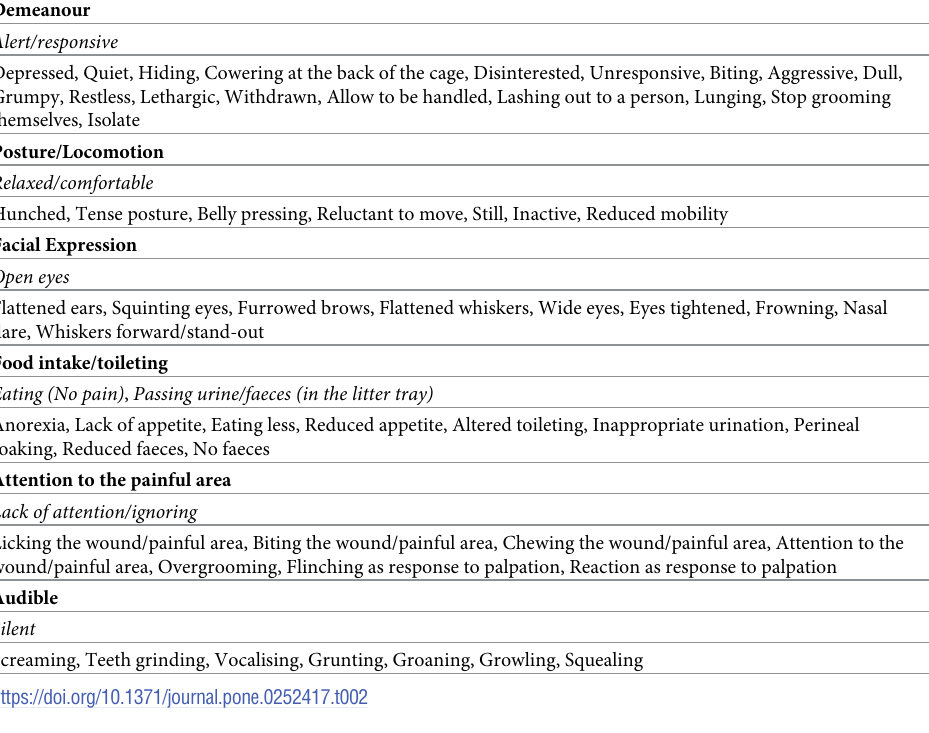
Table 2. Final descriptors and categories chosen during the specialist focus group in phase two. The ‘No Pain’ descriptors added during the focus group are presented in Italic